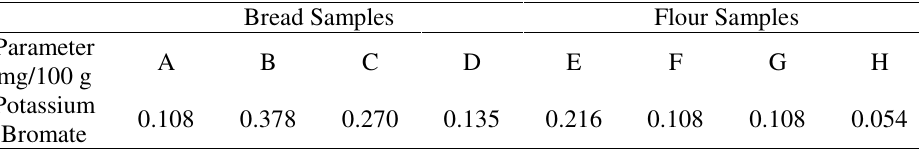
Table 2. Potassium bromate levels of some bread and flour samples in